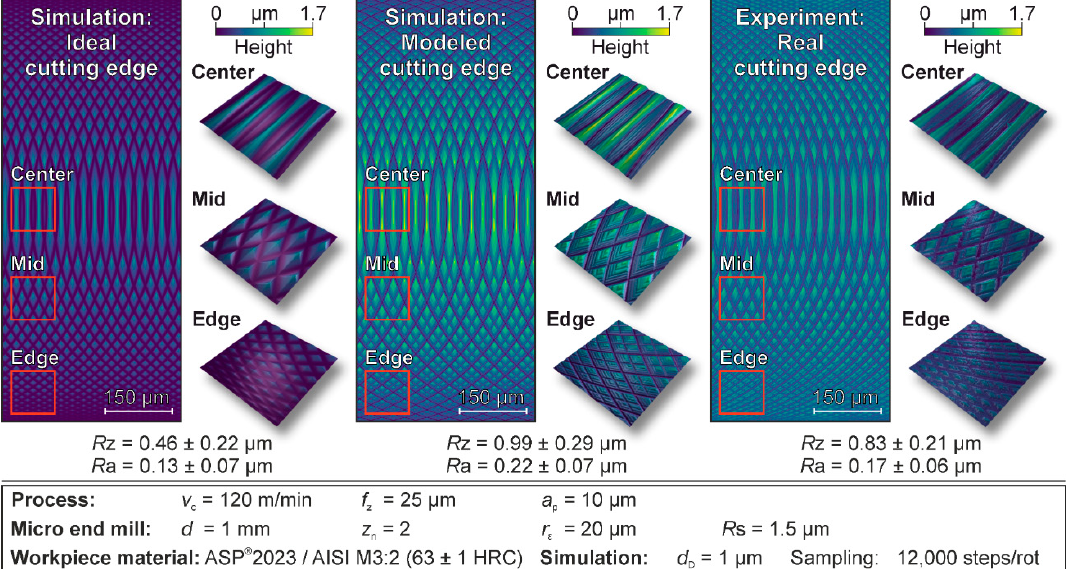
Figure 14. Influence of back cut on the surface topography.